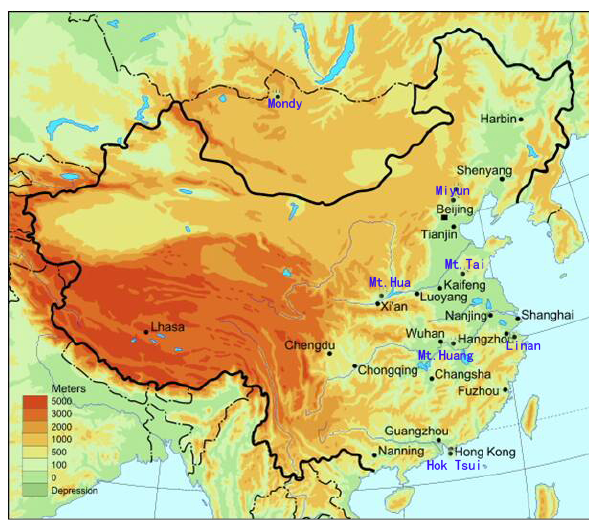
Fig. 7. Topography (meters) of China. The locations of the obser- vation sites shown in Figs. 1 and 2 are indicated as blue dots. Some selected big cities (black dots) are also